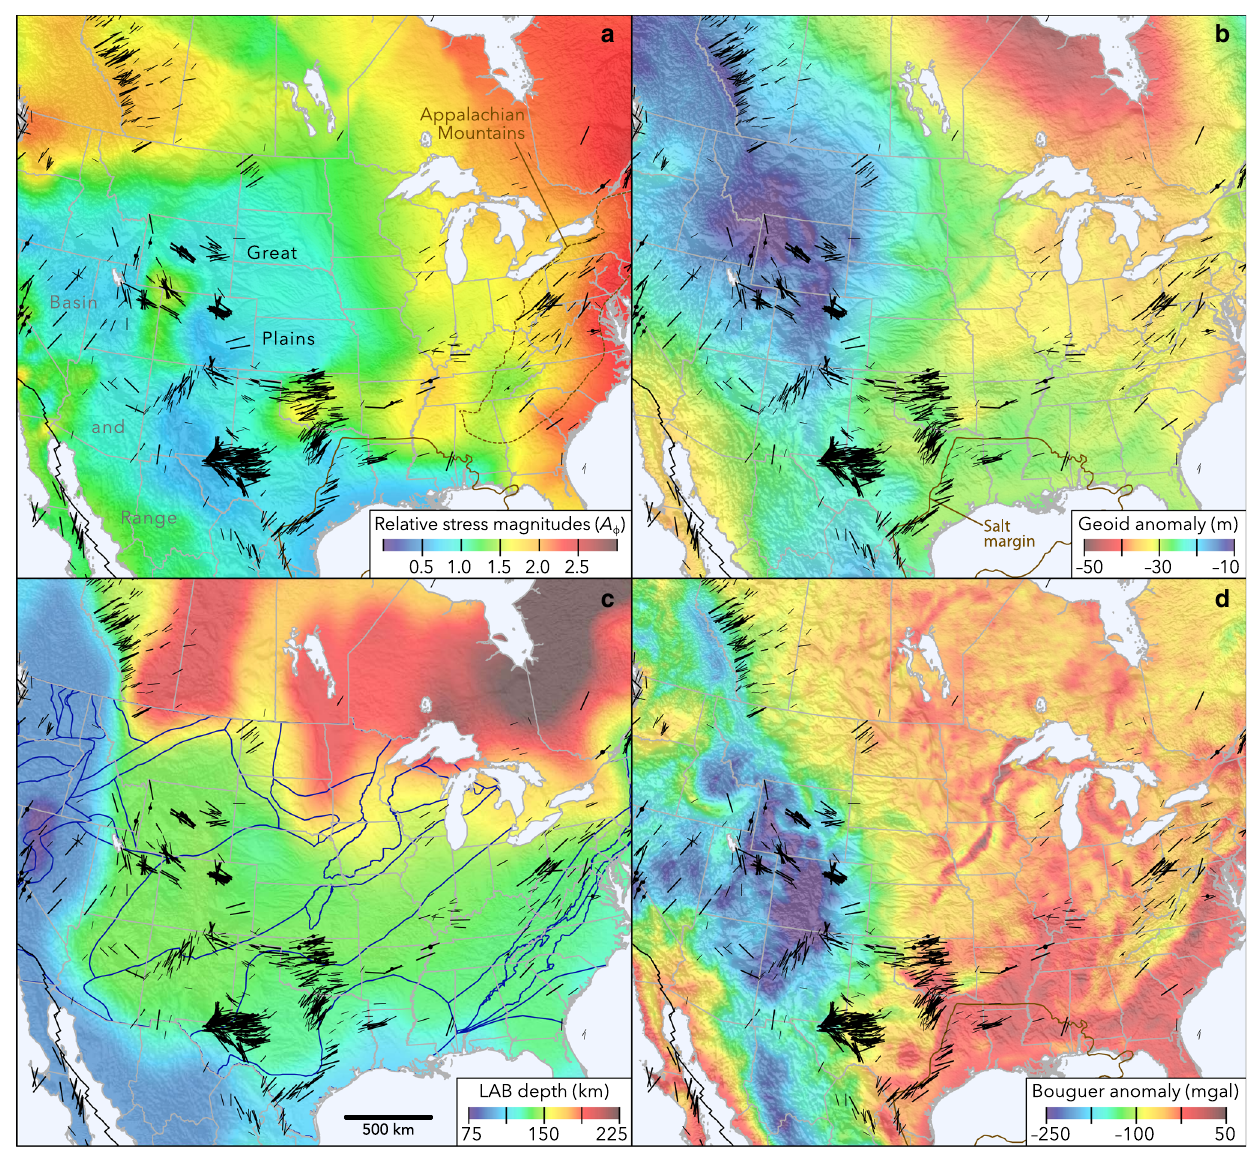
Fig. 3 Comparison between the state of stress and lithospheric data. a State of stress in the central and eastern USA and southeast Canada. For clarity, dense maximum horizontal stress ( S Hmax ) orientations in southern California are omitted. The Gulf of Mexico salt margin is from Pindell and Kennan 61 . b Geoid anomaly from Pavlis et al. 62 . c Lithosphere – asthenosphere boundary (LAB) depth from Artemieva 38 . Blue lines are crustal basement domain boundaries from Lund et al. 40 . d Bouguer gravity anomaly from Mooney and Kaban 29